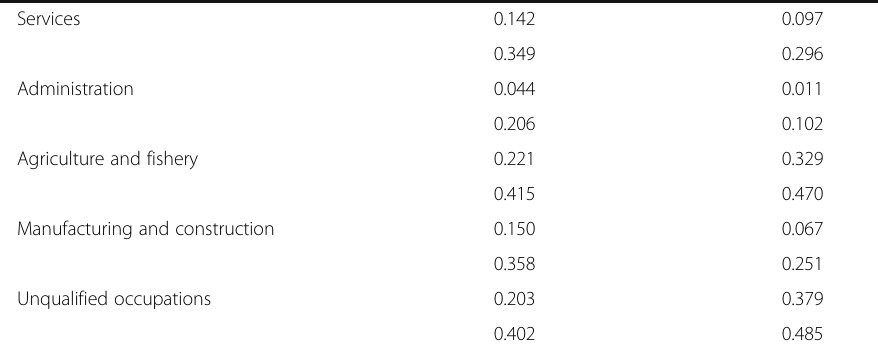
Table 1 Summary statistics by Spanish proficiency (Continued)